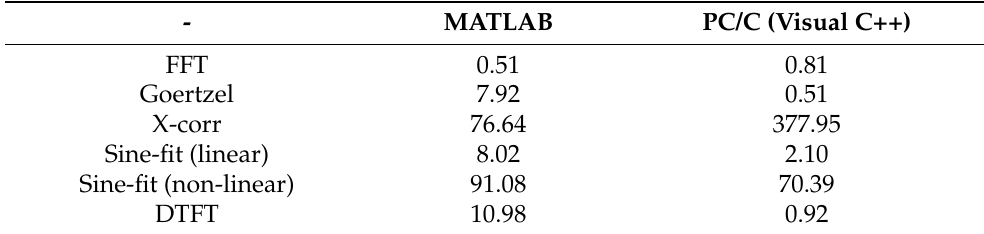
Table 7. Total AC signal analysis Processing Time as Implemented in MATLAB and Visual C++ in